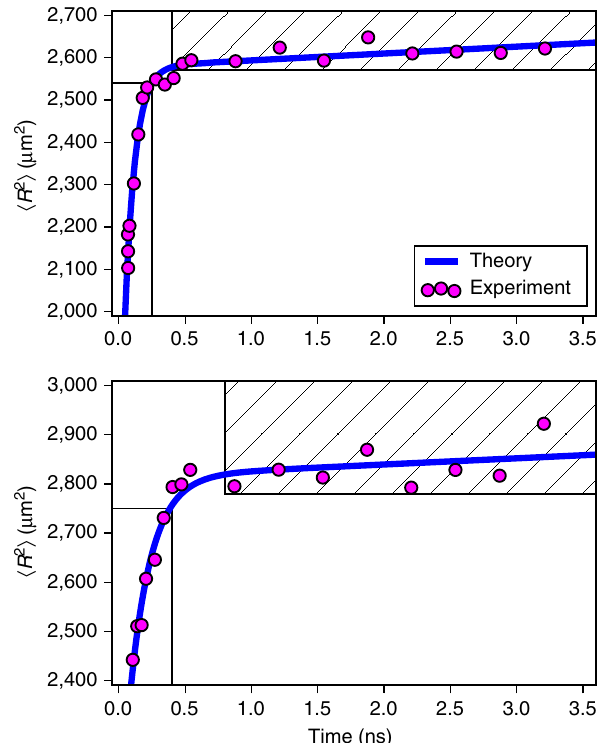
Figure 3 | Second moment and the two diffusion regimes. Time evolution of the second moment R 2 (cid:3) (cid:4) (equation (1)) of the spatial carrier distributions for excited electrons in p -type Si (top panel) and holes in n -type Si (bottom panel). The magenta circles are experimental data, and the blue line the numerical results obtained by solving the diffusion equation. The data in the boxes are used to obtain the transient diffusivity (empty box) and steady-state diffusivity (hatched box).